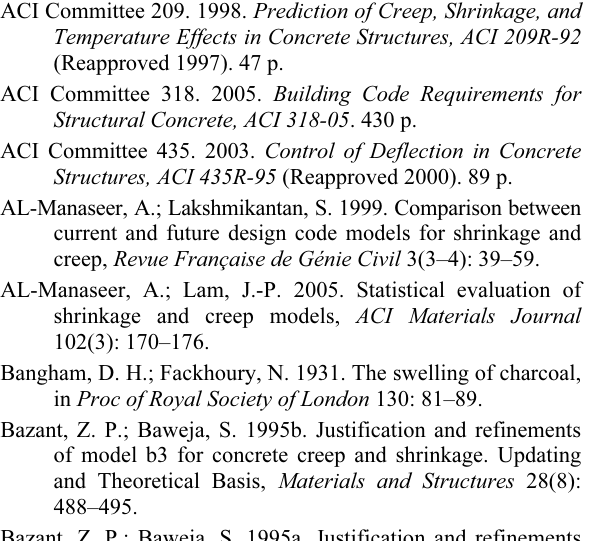
Fig. 10. Numerical modelling of test beams (Фигаровс- кий [Figarovskij] 1962): stress-strain relationship used in the numerical analysis (a) and calculated moment- deflection relationships